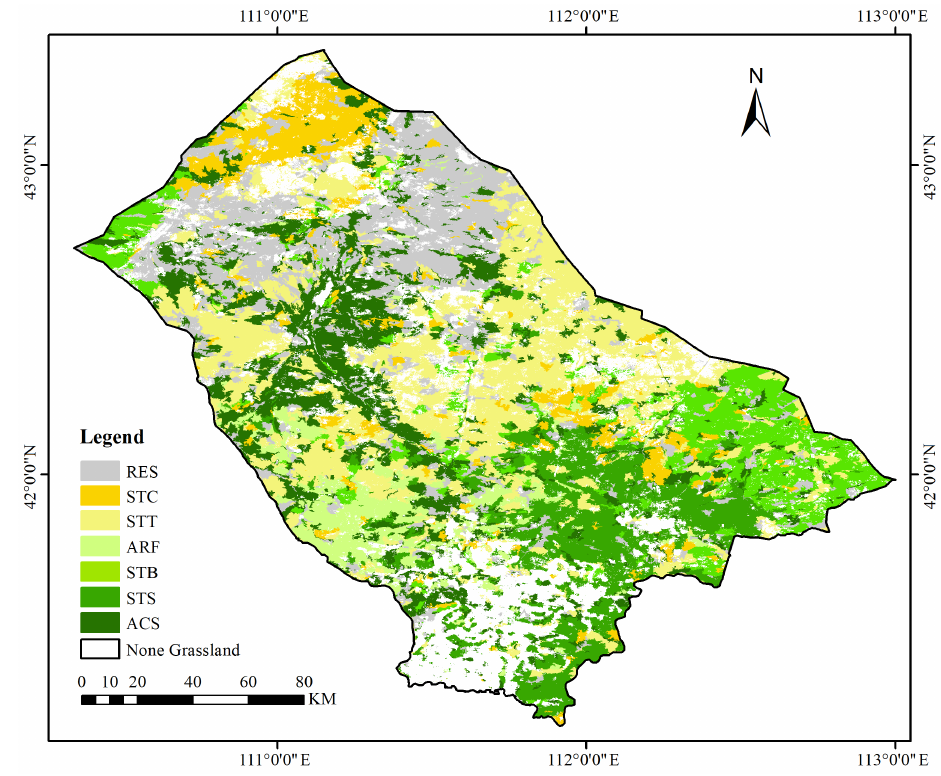
Figure 11. The classification results of Siziwang grassland